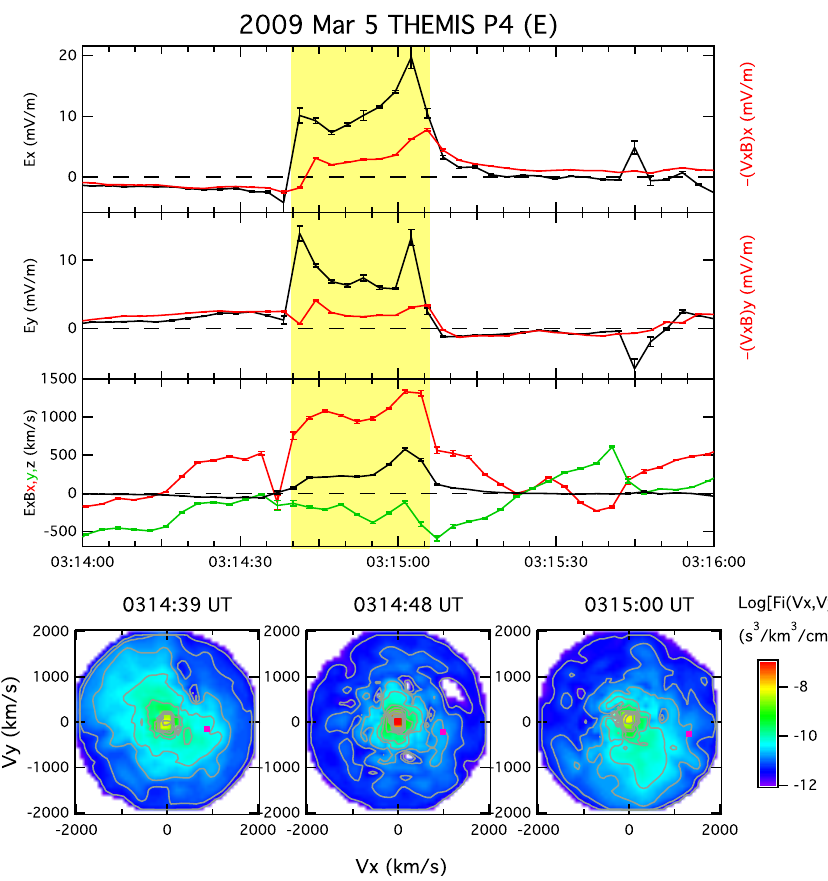
Fig. 8. Observations for the current disruption/dipolarization event on 5 March 2009. The parameters shown and the format are same as Fig.